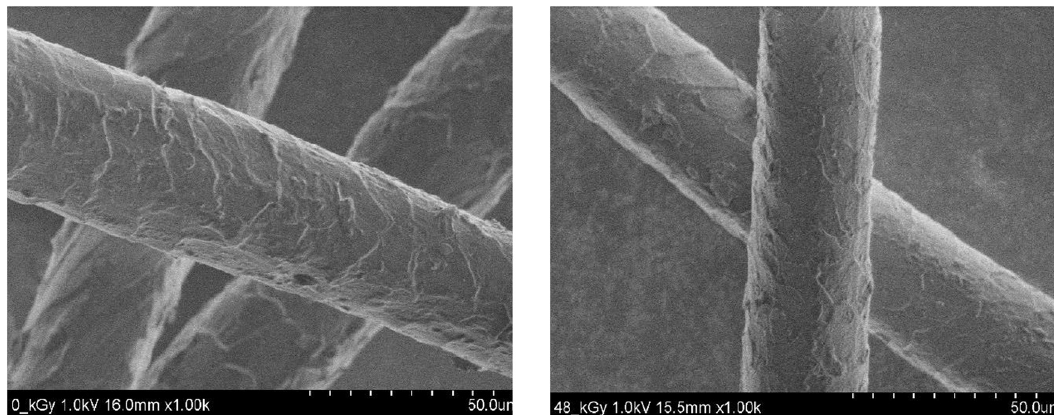
Figure 2: SEM images of the non - irradiated ( left ) and irradiated ( right ) fi